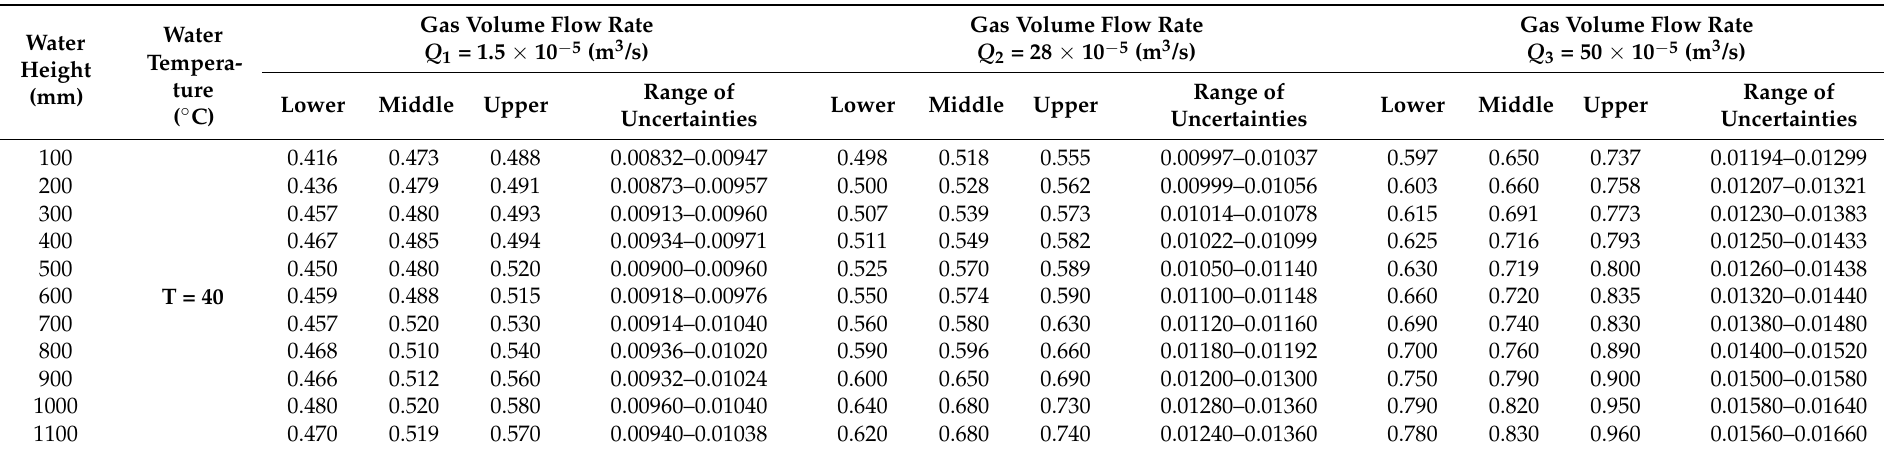
Table 8. Bubble speed (m/s) as a function of water height for T = 40 ◦ C and for gas volume flow rates Q 1 –Q 3 .